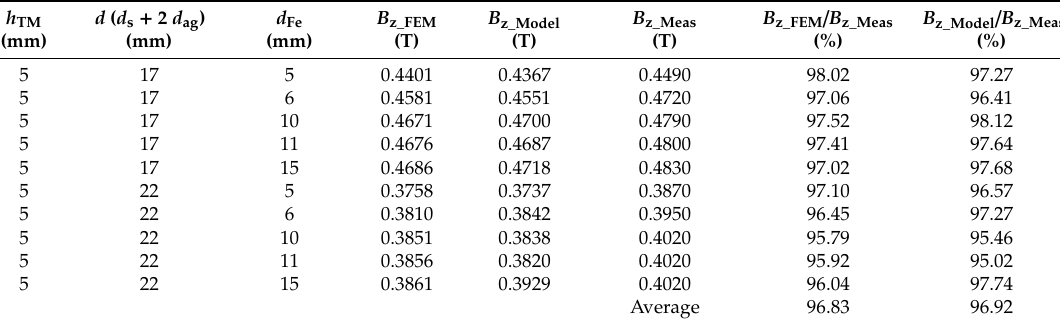
Table 10. Measurements of the B z and comparison with the calculated